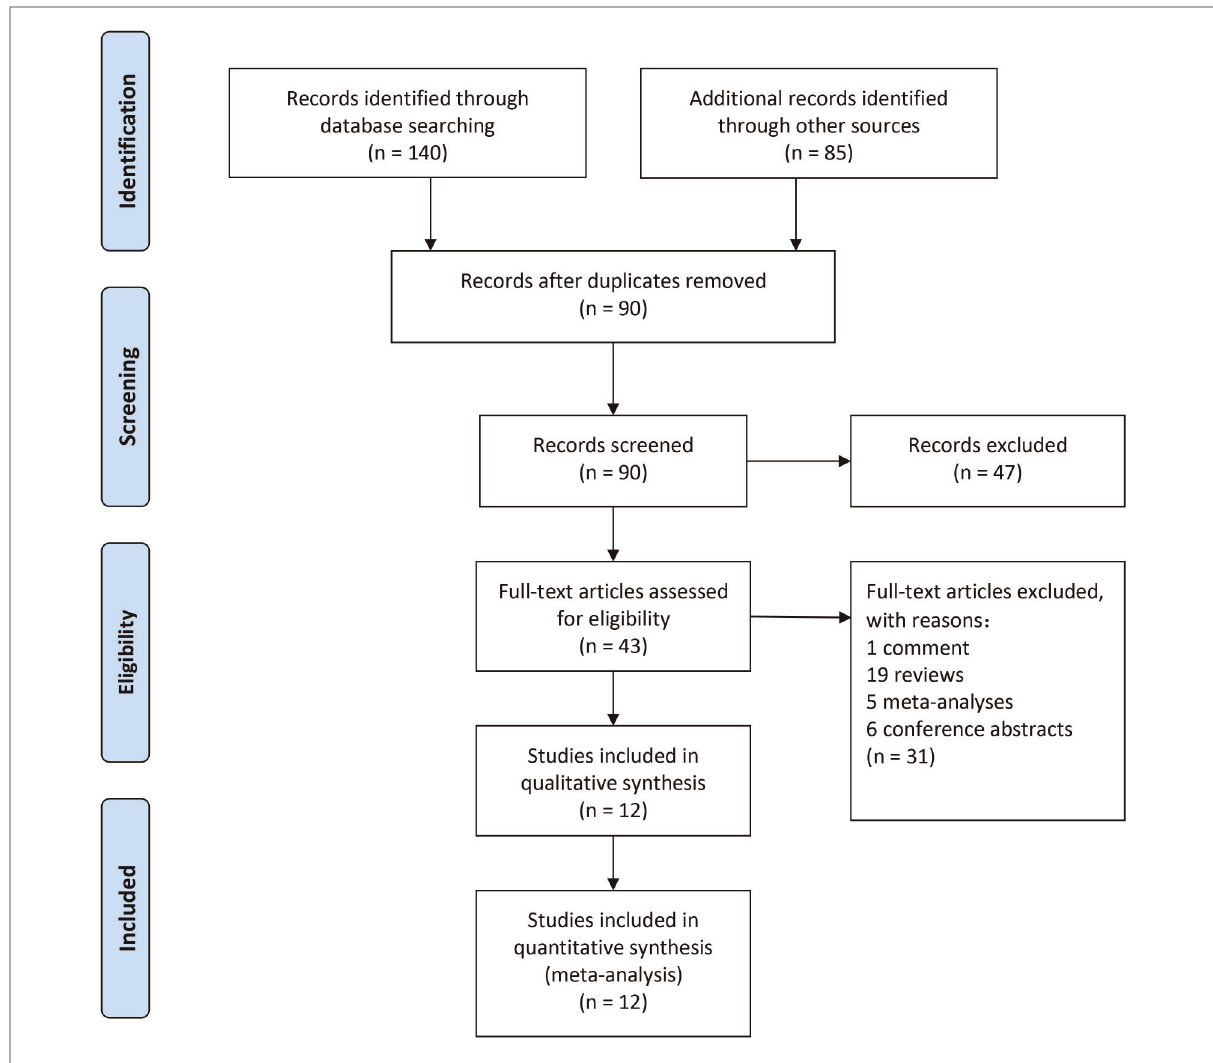
FIGURE 1 Study fl ow chart (as per PRISMA